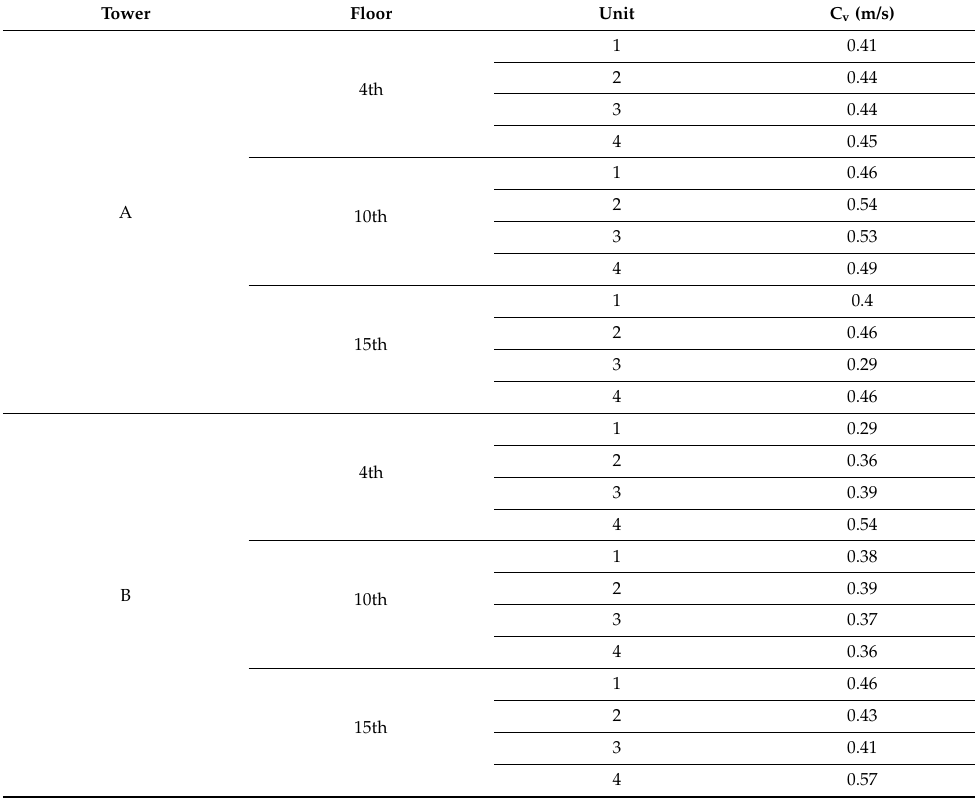
Table 10. Reference air movement at the measured